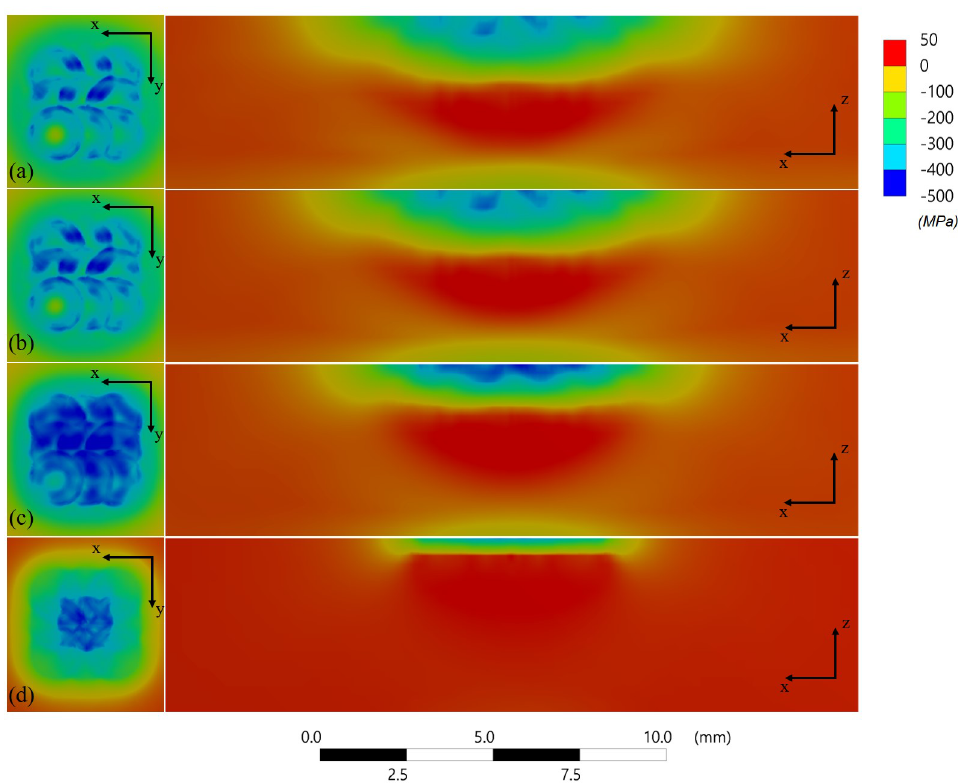
Figure 16. Minimum principal stress of multiple LSP FE solution. Top (x–y plane) and cross-section (x–z plane) view: ( a ) R d = 0; ( b ) R d = 4.6 × 10 − 5 ; ( c ) R d = 50 × 10 − 5 ; ( d ) R d = 500 × 10 − 5 .